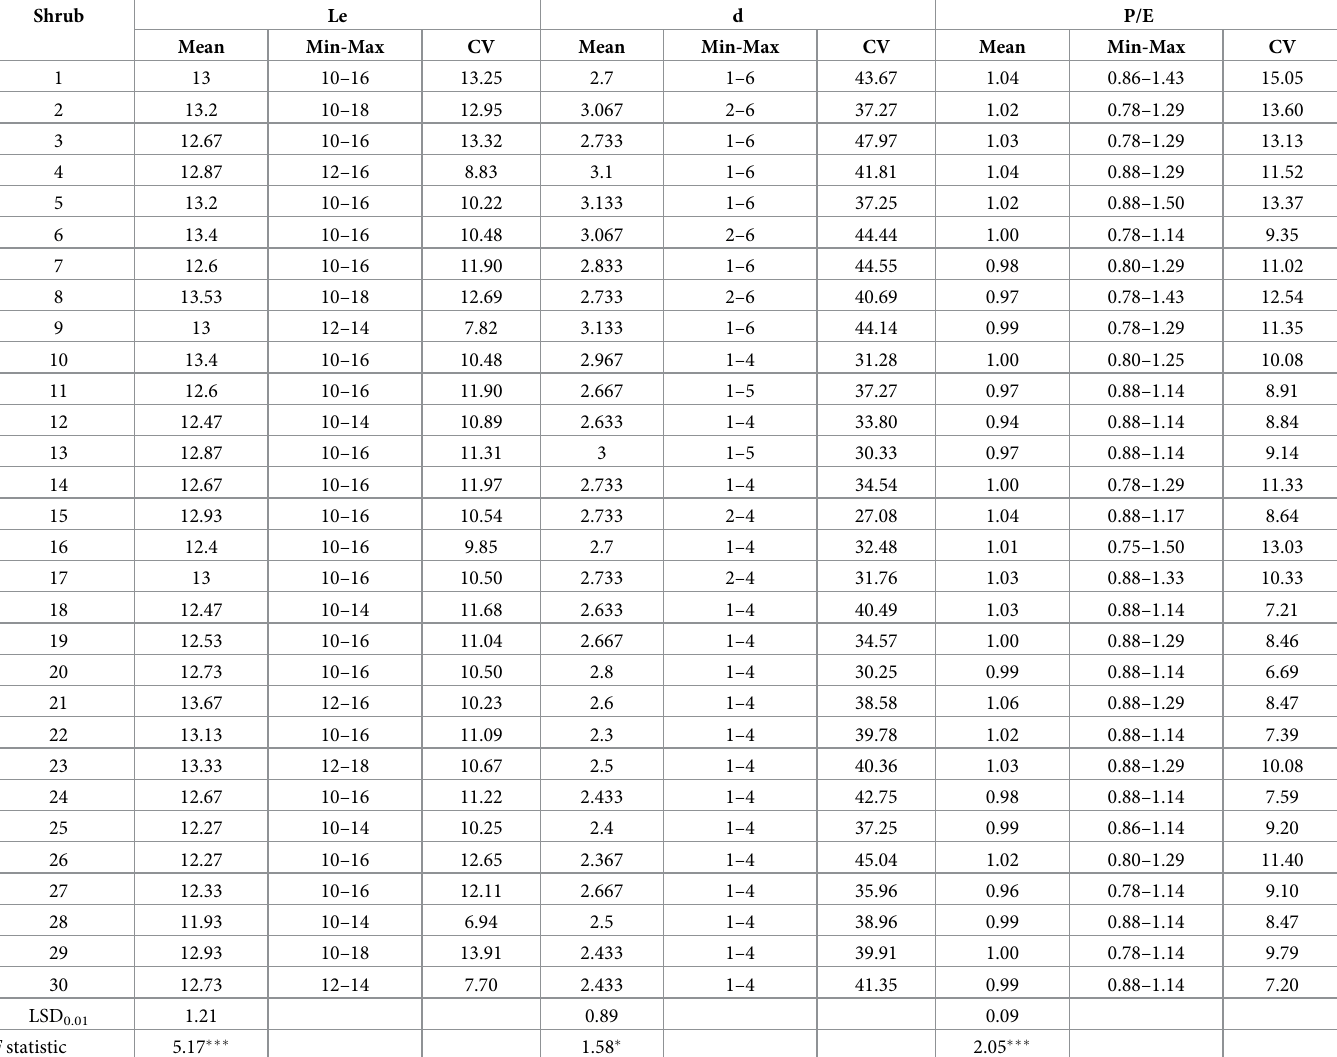
Table 3. Minimal, maximal and mean values as well as coefficients of variation (CV) for Le, d and P/E ratio of